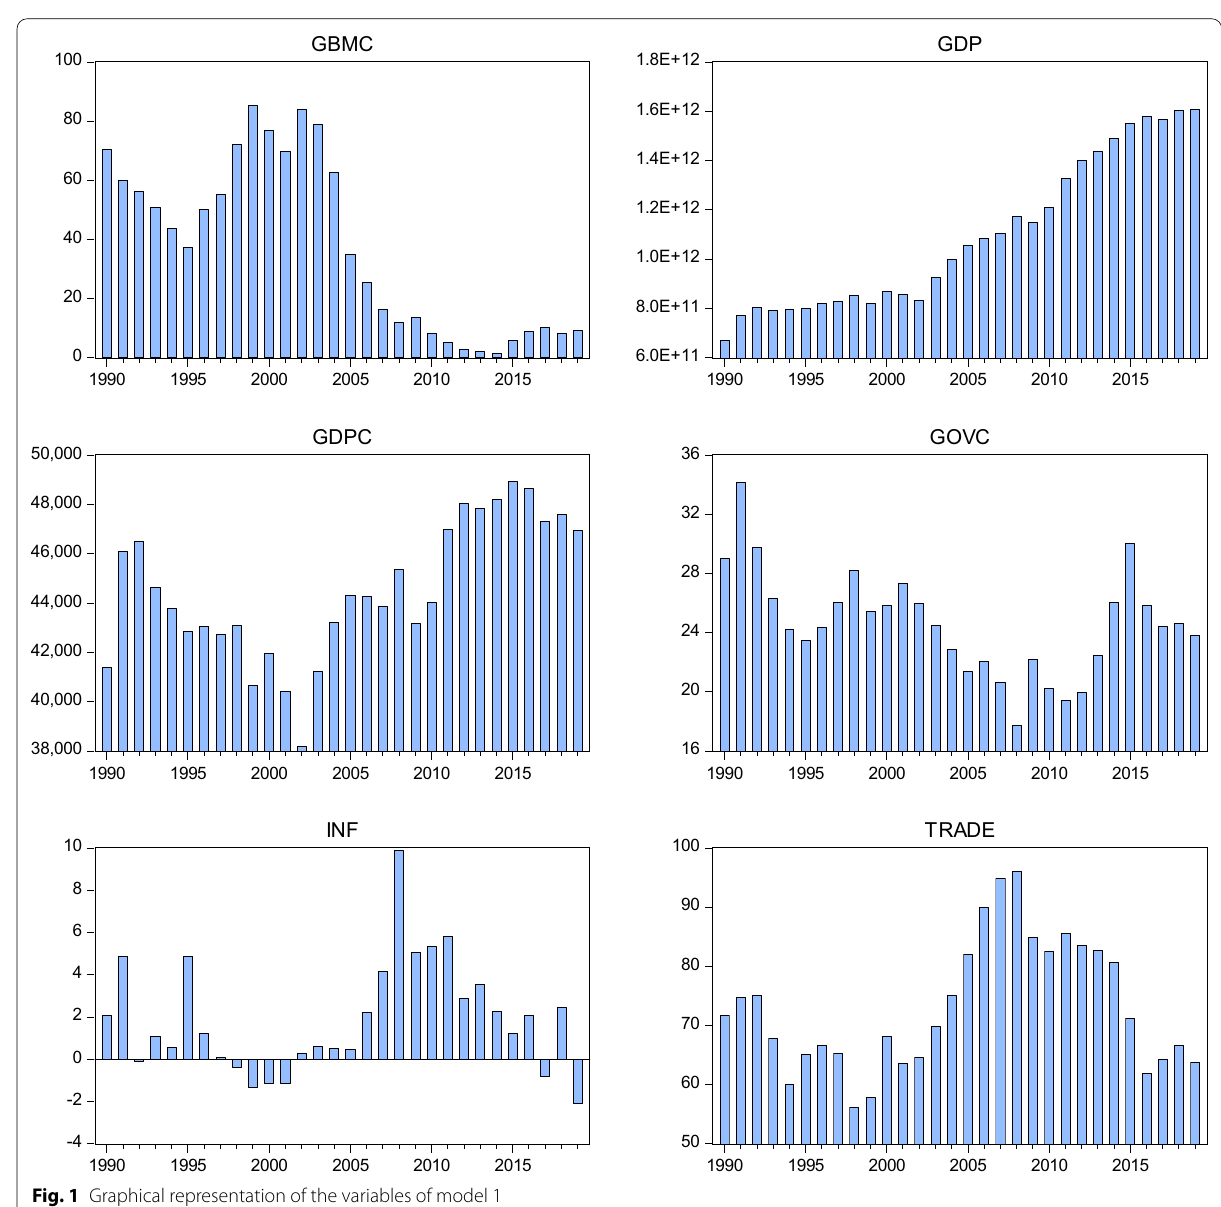
Fig. 1 Graphical representation of the variables of model